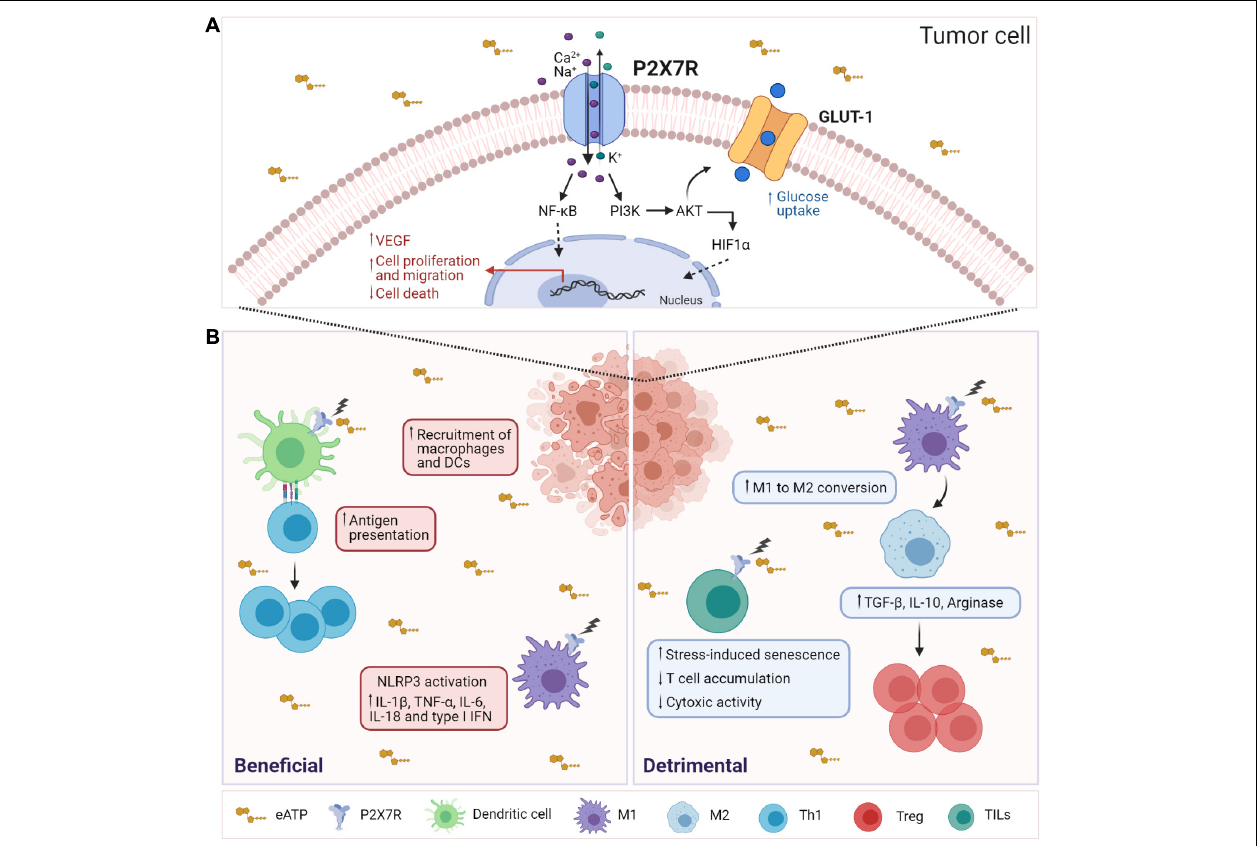
FIGURE 1 | Influence of P2X7R activity on tumor and immune system cells. (A) In tumor cells, P2X7R stimulation by eATP results in Ca 2 + influx, activation of MyD88/NF- κ B, PI3K/Akt/mTOR signaling pathways leading to nuclear translocation of Hif1 α and Nf- κ B, enhancement of cell proliferation, cell migration, and VEGF secretion. Moreover, stimulation of P2X7R upregulates the glucose transporter GLUT-1, fostering the glycolytic pathway and oxidative phosphorylation that allow tumor cells to proliferate in vitro in the absence of serum. (B) (Left) In the TME, extracellular ATP is released by tumor-dying cells and may function as a DAMP (danger-associated molecular pattern), inducing the recruitment and activation of macrophages and DCs. Activation of P2X7R by eATP triggers several responses in DCs, such as maturation, migration, and antigen presentation. Moreover, K + release leads to NLRP3 inflammasome activation and secretion of proinflammatory cytokines such as IL-1 β , TNF- α , IL-6, IL-18, and type I IFN. (Right) P2X7R activation promotes immunosuppression by MDSCs by stimulating the release of ROS, arginase 1 (ARG1), and TGF- β 1, which, in turn, leads to Tregs expansion. Moreover, P2X7R promotes the conversion of M1 macrophages to M2. P2X7R activity in TILs fosters stress-induced cellular senescence, thus limiting their expansion and cytotoxic